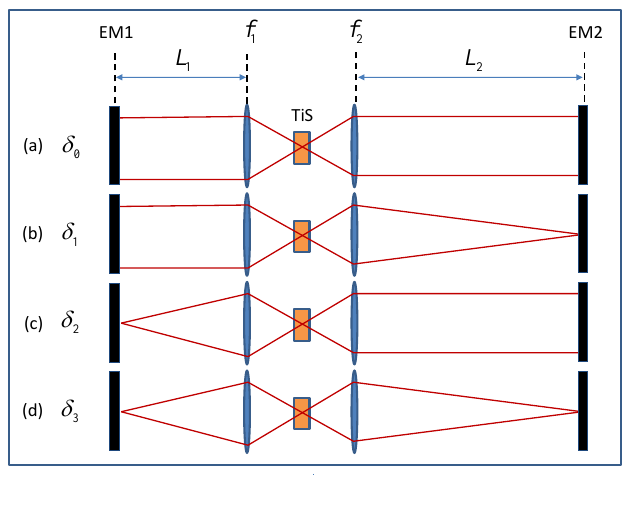
Figure 2. Geometrical representation of the cavity mode at the stability limits: ( a ) plane-plane limit; ( b ) plane-point limit; ( c ) point-plane limit; ( d ) point-point